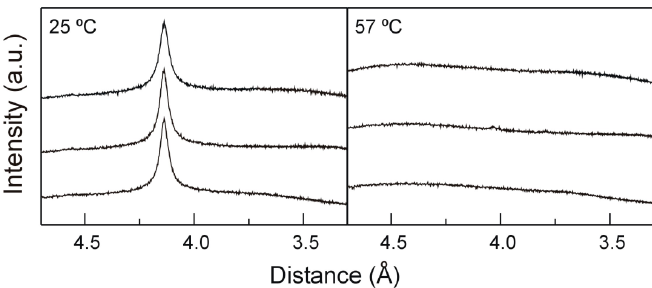
Figure 4. Wide angle X-ray diffraction profiles of pure DMPE and mixtures with TMCG. Gel phase ( left , 25 °C) and liquid crystalline phase ( right , 57 °C). From top to bottom: pure DMPE, DMPE containing 0.07 mol fraction TMCG, DMPE containing 0.25 mol fraction TMCG.